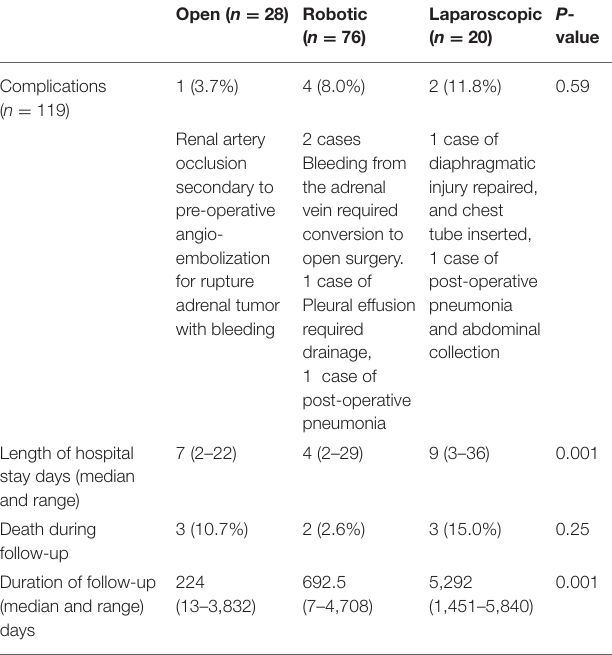
TABLE 5 | Complications and outcome based on the surgical